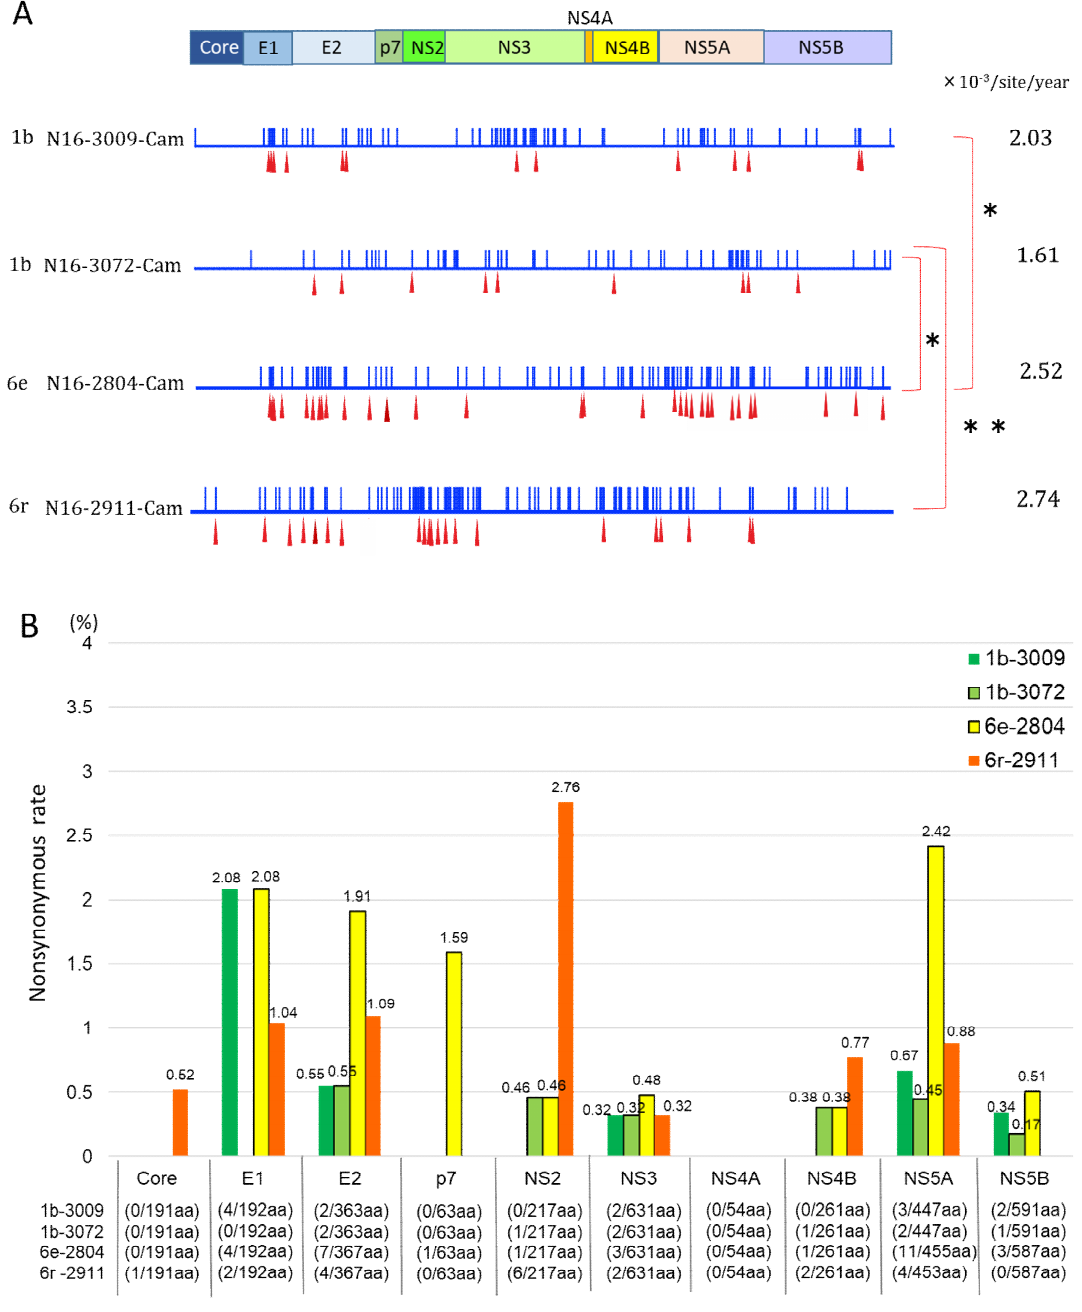
Figure 4. Mutation sites and the rate of nonsynonymous substitution of HCV RNA. ( A ) Nucleotide and amino acid mutation sites of HCV RNA among four Cambodian subjects. Blue bar indicates nucleotide mutation; red triangles indicate amino acid mutations. A significant difference (*, **) in mutation rate was observed between genotypes 1b (No.3009) and 6e (No.2804) ( p < 0.0001); 1b (No.3009) and 6r (No.2911) ( p = 0.042); 1b (No.3072) and 6e (No.2804) ( p < 0.0001); and 1b (No.3072) and 6r (No.2911) ( p = 0.00070). However, there was no significant difference between genotypes 1b (No.3009) and 1b (No.3072) ( p = 0.18) or 6e (No.2804) and 6r (No.2911) ( p = 0.55). ( B ) The rate of nonsynonymous substitution in each area of HCV RNA in the same four Cambodian subjects. The numbers of nonsynonymous substitutions per area of HCV RNA are described in each of 10 areas.